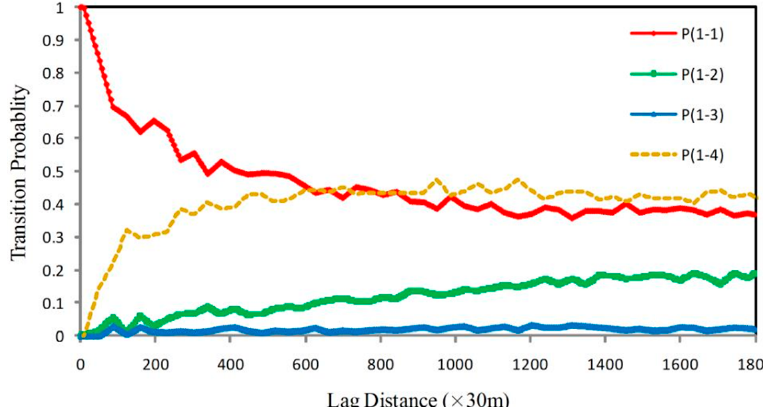
Figure 4. A subset of transiogram models estimated from the expert-interpreted sample data for the Cixi case study. P(1-1) denotes the auto transition probability of built-up area. P(1-2) denotes the cross-transition probability from built-up area to woodland. P(1-3) denotes the cross-transition probability from built-up area to waterbody. P(1-4) denotes the cross-transition probability from built-up area to farmland. Lag is the separate distance between a pair of data points.